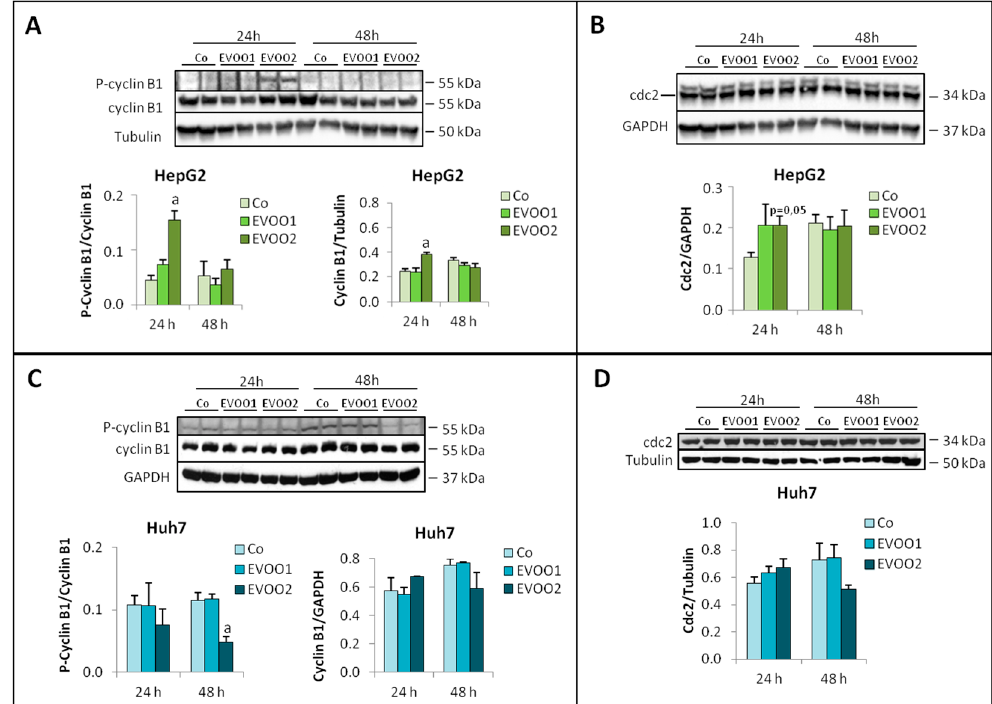
Figure 3. EVOO extract modulates the expression of the cyclinB1/cdc2 complex. The cell lines were incubated for 24 and 48 h with two different doses of the phenolic extract. ( A , B ) Expression of P-Cyclin B1 and cdc2 in HepG2 cell line. ( C , D ) Expression of P-Cyclin B1 and cdc2 in Huh7 cell line. The results are representative of three experiments. The protein molecular weights are reported. Data are presented as mean ± SD. (a: p < 0.05 versus Control).